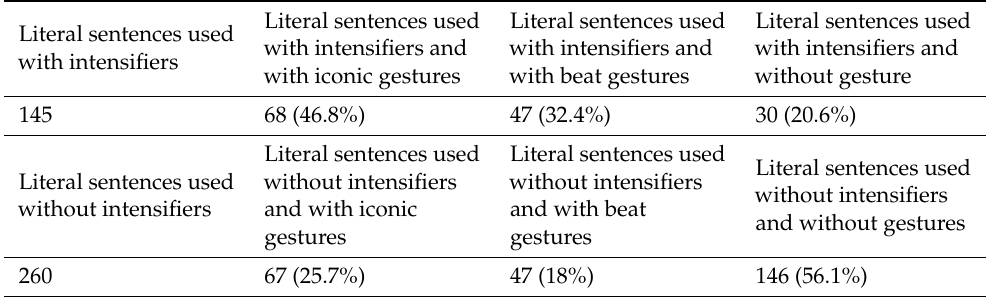
Table 1. Number of literal sentences used with/without an intensifier and with iconic/beat